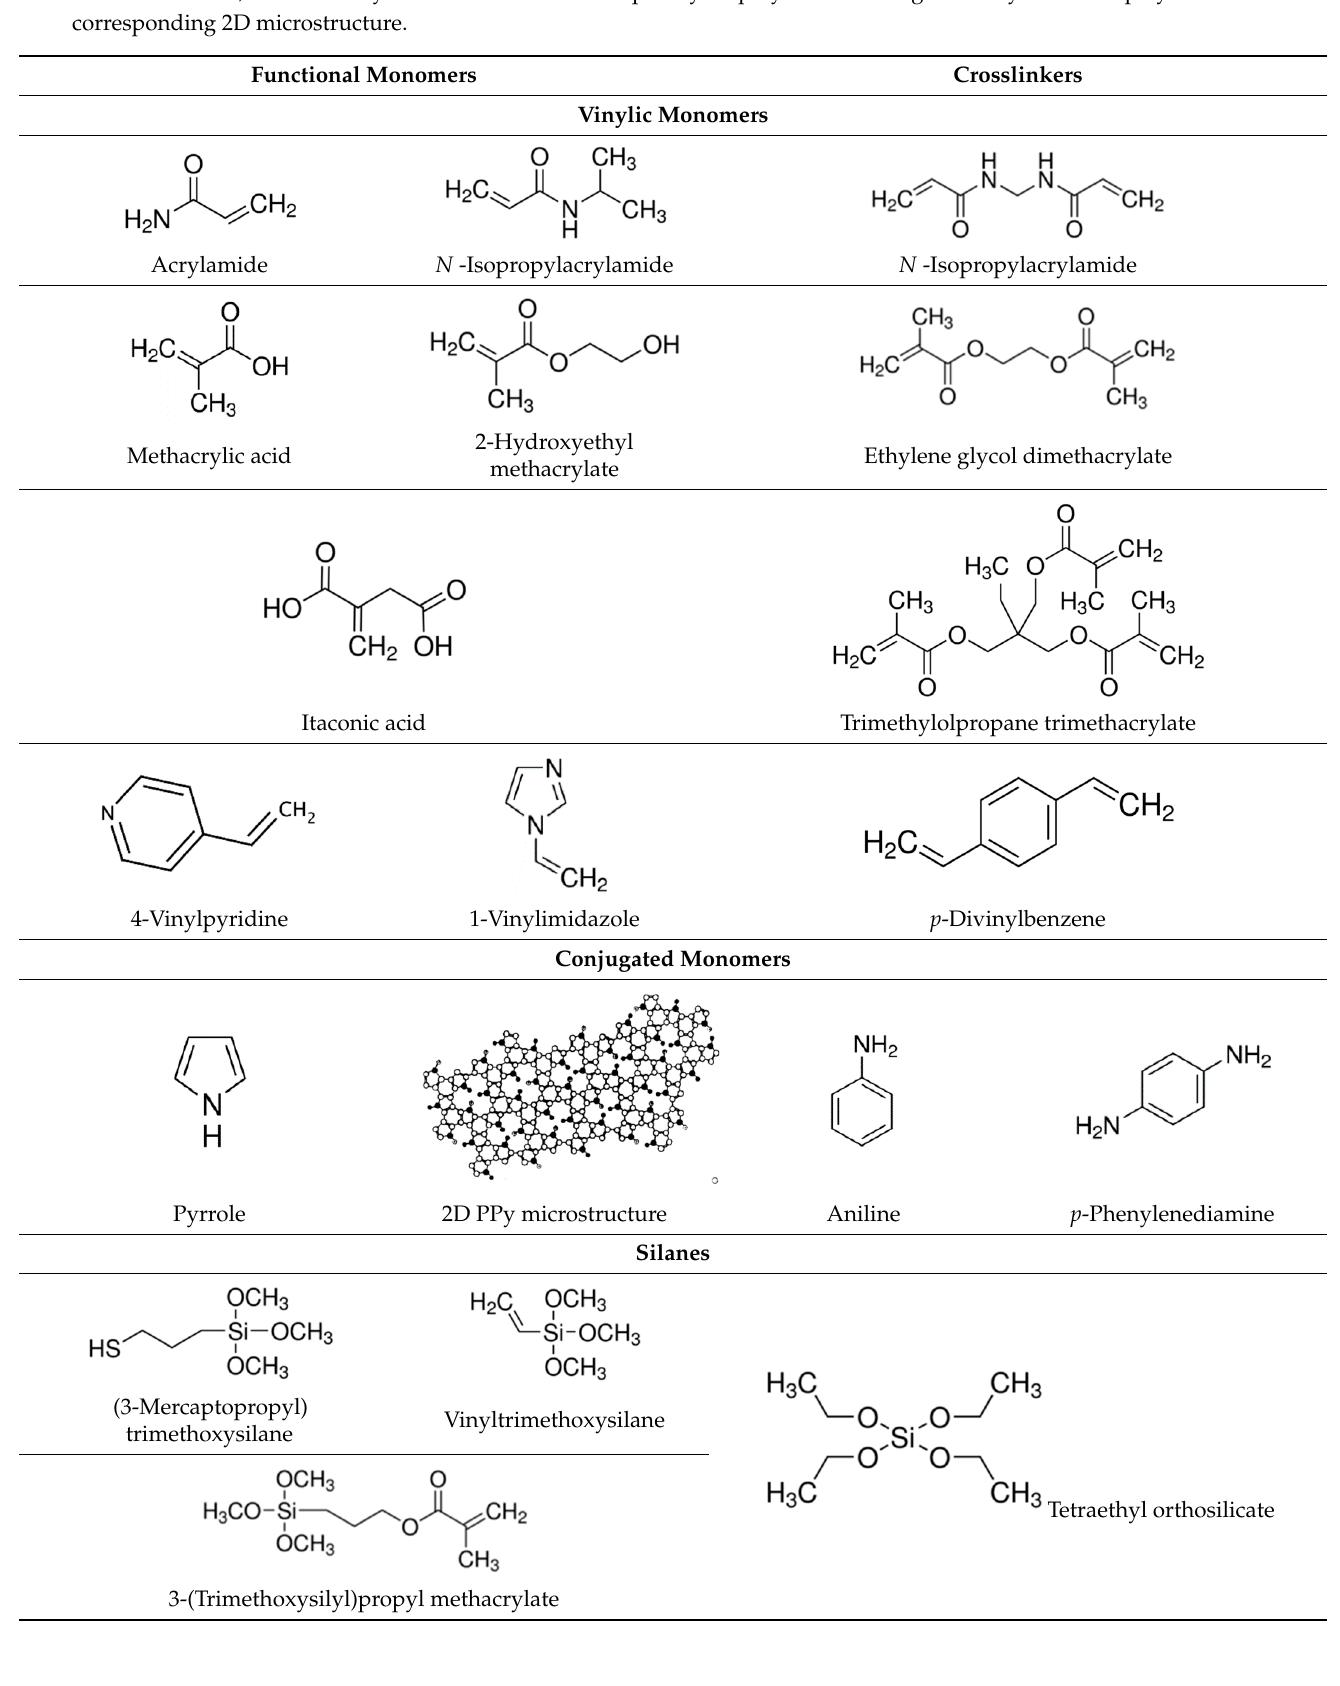
Figure 2. Screenshot of Dickey’s paper: Chemical structure of methyl orange and results of its relative adsorption (Adapted from [33]; paper in public domain). 3.1.1. Vinylic Imprinted Polymers Most imprinted vinylic polymer powders, nanocomposites and coatings are pre- pared via free radical polymerization using AIBN, Irgacure or potassium persulfate. Free radical or photoinduced radical polymerization or controlled photopolymerization (such as photo-iniferter [35,36], INItiation–TransFER–TERminaison agent) is ideal as it does not require heating and could be achieved within minutes to a few hours. In the case of grafted imprinted polymers, photopolymerization is unique for its spatiotemporal as- pect. The polymer can be grafted on a selected area and growth be controlled with irra- diation time. Ion imprinted clay-polymer nanocomposites have recently been prepared by radical photopolymerization under visible [37] or UV light [38] using Type II pho- toinitiators. For grafted MIP thin films prepared by surface confined photopolymeriza- tion, the reader is referred to [39,40]. Figure 3 shows a simplified mechanism of radical polymerization whether it is of the free radical or controlled type. Initiator is activated thermally or photochemically and the initiating radical triggers polymerization of the prepolymerization complex (PCC) to yield, after a few hours or even better a few minutes (in the case of photopolymerization), 3D crosslinked polymers with entrapped template species (T). Precipitation polymeriza- tion requires crashing of the former monolith, but, in the case of the synthesis of im- printed thin polymer film, it is essential to first prepare graft initiators to the electrode in order to confine polymerization to the surface and limit precipitation of imprinted pol- ymers or interpenetration of grafted polymers with free crosslinked polymers; this makes